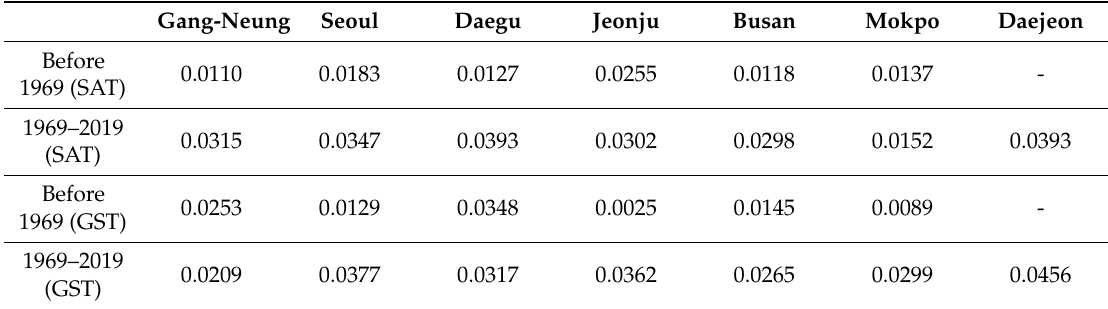
Table 1. Linear regression slopes of the annual mean SAT and GST ( ◦ C / year).